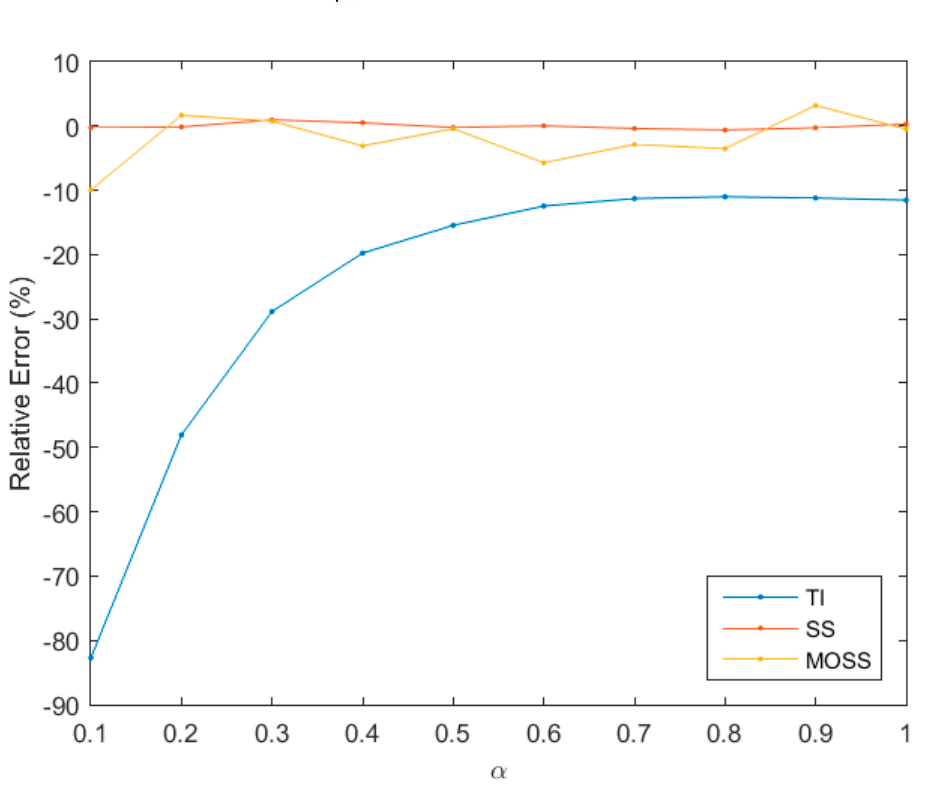
Figure 1. Bayesian model evidence (BME) estimation for the Gaussian model with D = 100 dimensions and K = 5 using thermodynamic integration (TI), steppingstone sampling (SS), and multiple one-steppingstone sampling (MOSS). The relative error (%) of the mean BME is based on 10 independent estimations.